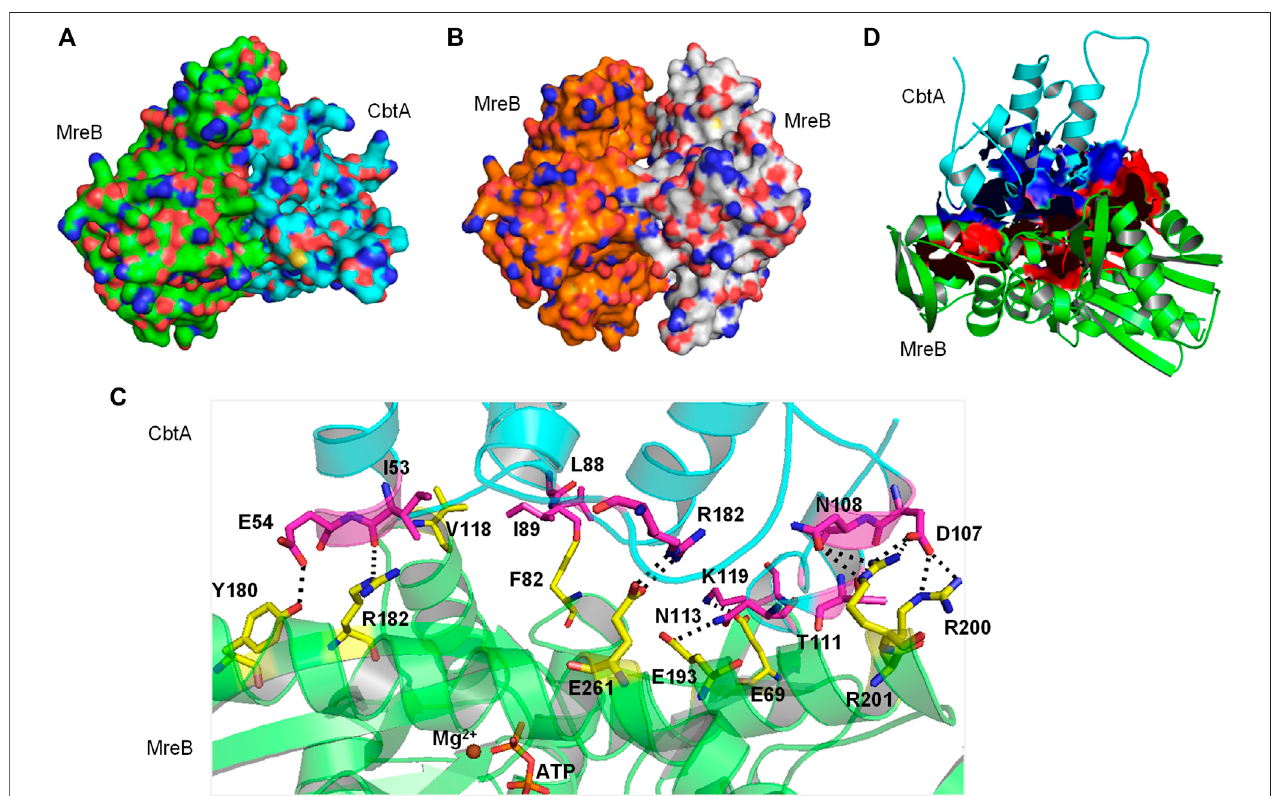
FIGURE 8 | The MreB-CbtA interaction data. (A) Space- fi lling model of the MreB-CbtA complex. Carbon atoms of MreB and CbtA are colored green and cyan, respectively. (B) Space- fi llingmodeloftheMreB-MreBcomplex.CarbonatomsofChainAandChainBarecoloredorangeandgray,respectively. (C) Keyinteractionsat the MreB-CbtA interface. Carbon atoms of MreB and CbtA are colored green and cyan, and the carbon atoms of the corresponding amino acid residues involved in the interactions are colored yellow and magenta, respectively. Oxygen and nitrogen atoms are colored red and blue, respectively. Hydrogen bonds are illustrated by black dashes. (D) Phobic interactions at the MreB-CbtA interface. Carbon atoms of MreB and CbtA are colored green and cyan, respectively. Atoms constituting the phobic interfaces of MreB and CbtA are colored red and blue,